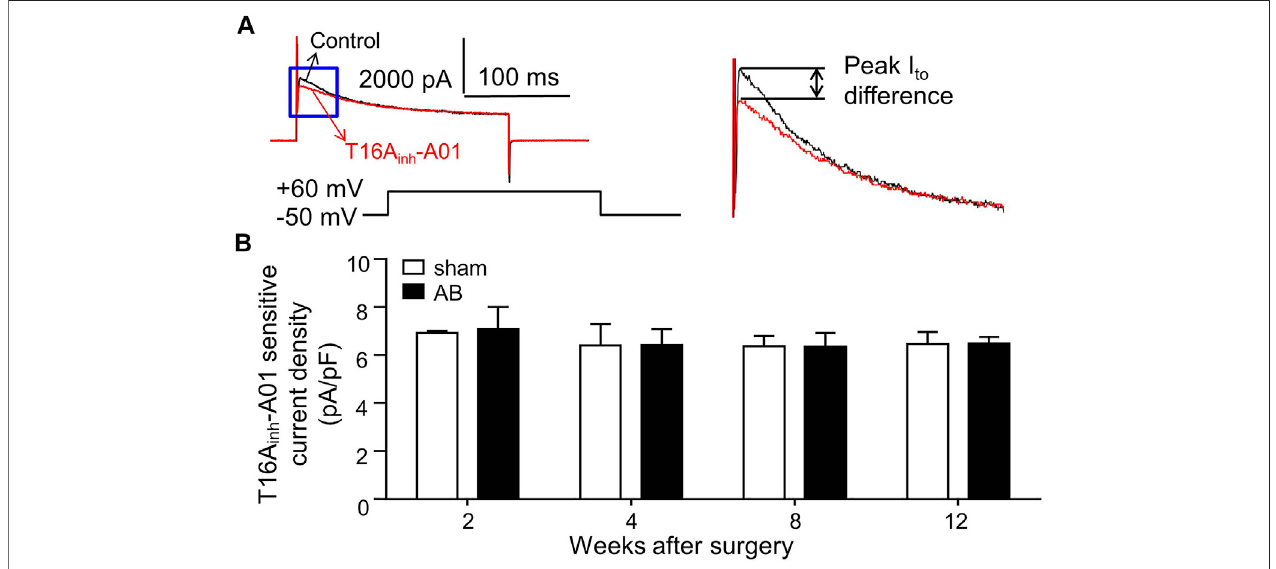
FIGURE 3 | I TMEM16A in LVMs. (A) Superimposed current tracings were recorded from the same cell before (control) and after exposure to 30 μ M T16A inh -A01. Right panelshows expandedtraces intheblue boxofleftpanel. (B) BargraphsshowaverageT16A inh -A01sensitivecurrentdensities inLVMs ( n =7 — 8cellsfrom three mice in each group per time point, RM two-way ANOVA).